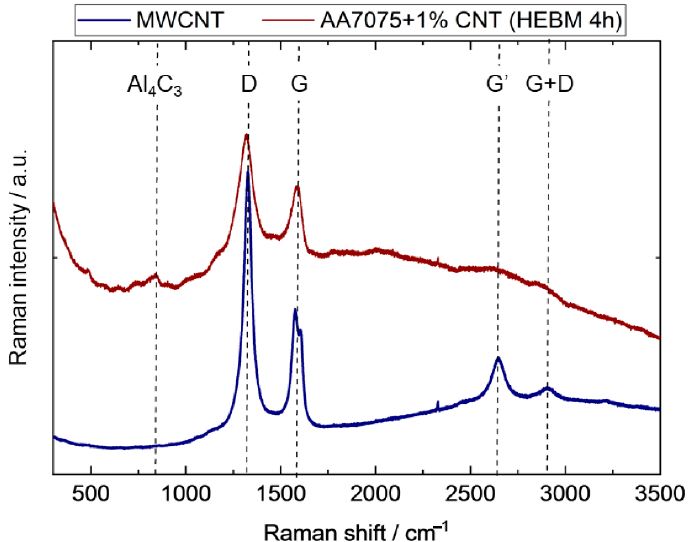
Figure 11. Raman Spectra of as-received MWCNTs and the composite containing 1 wt.% MWCNTs obtained after 4 h of HEBM.